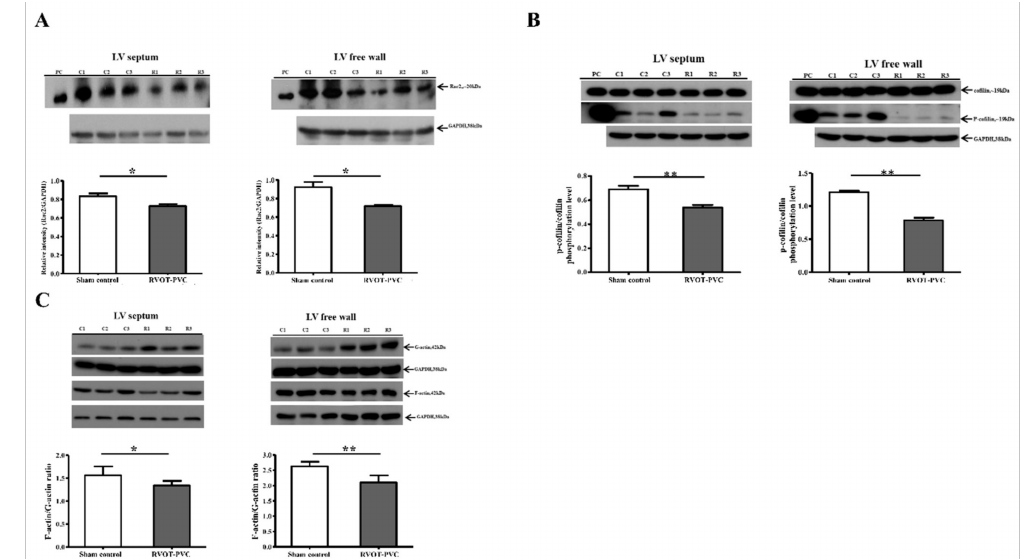
Figure 6. The expression of Rac2, phosphorylation of cofilin and F-actin/G-actin ratio in the LV myocardium following 6-month RVOT bigeminy VPC. Immunoblotting study showed that the expressions of ( A ) Rac family small GTPase 2 (Rac2), ( B ) Ratio of p-cofilin/cofilin, and ( C ) F-actin/G-actin ratio in left ventricular (LV) septum and LV free wall were significantly decreased in the RVOT bigeminy VPC group compared to the sham control group at the 6-month follow-up. *: p < 0.05; **: p < 0.01. PC: positive